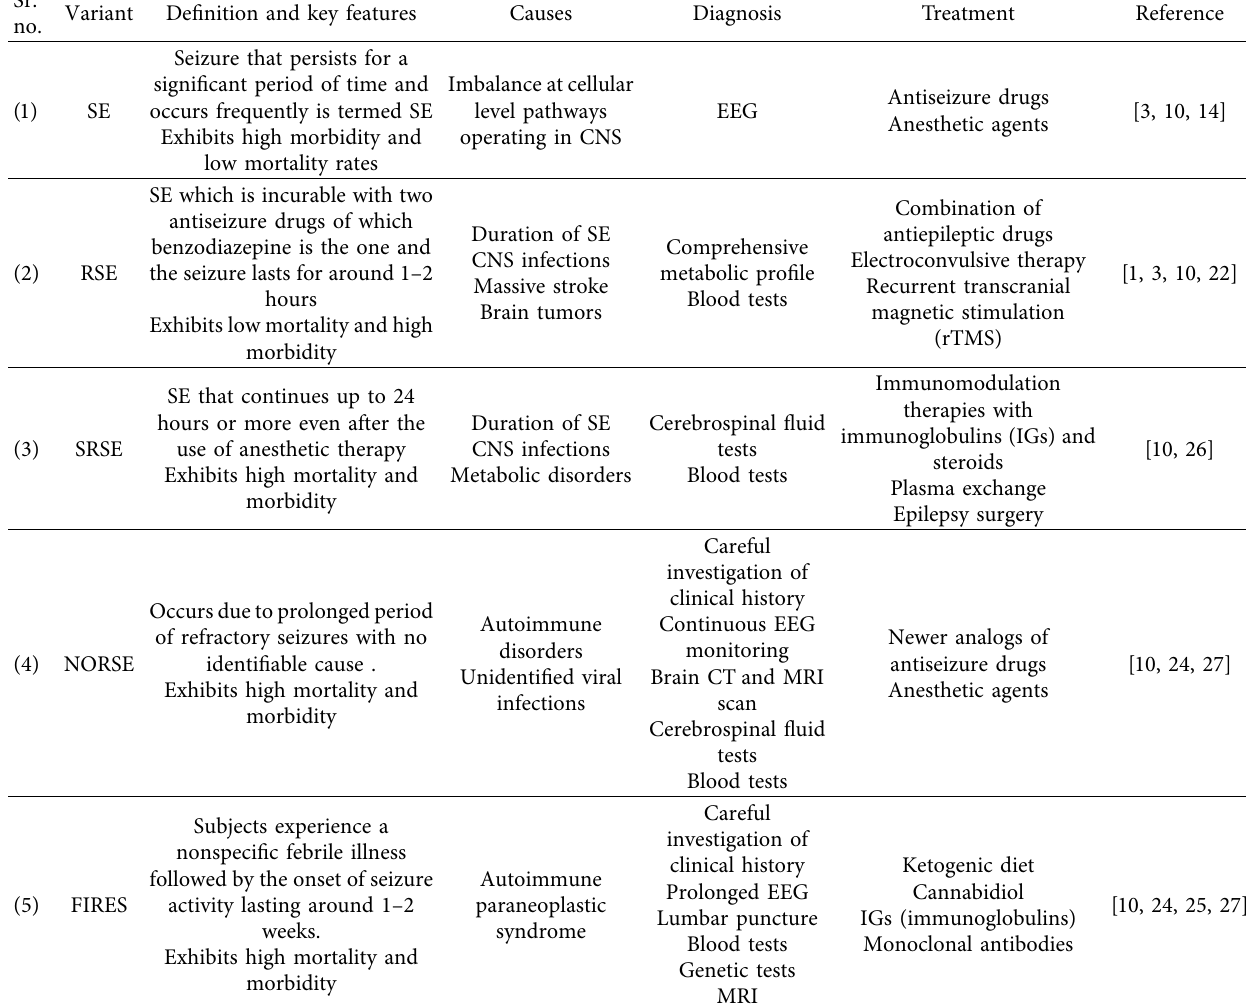
Table 3: Consolidated summary of SE and its